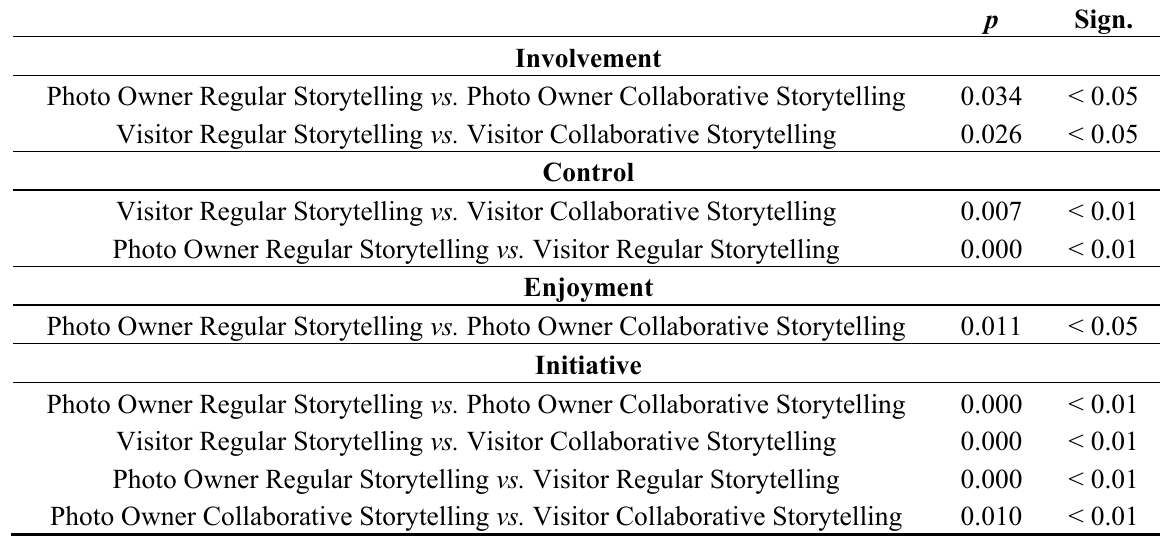
Table 4. Differences between test conditions or participants from the dyad experiment.